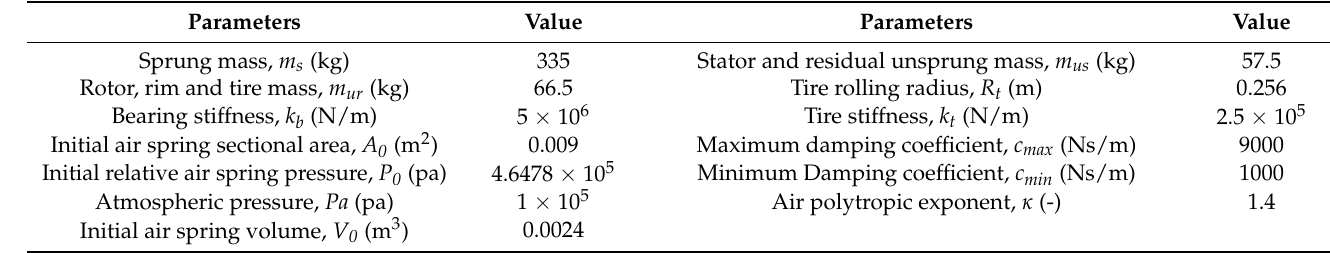
Table 2. Parameters of quarter HM-EV model.